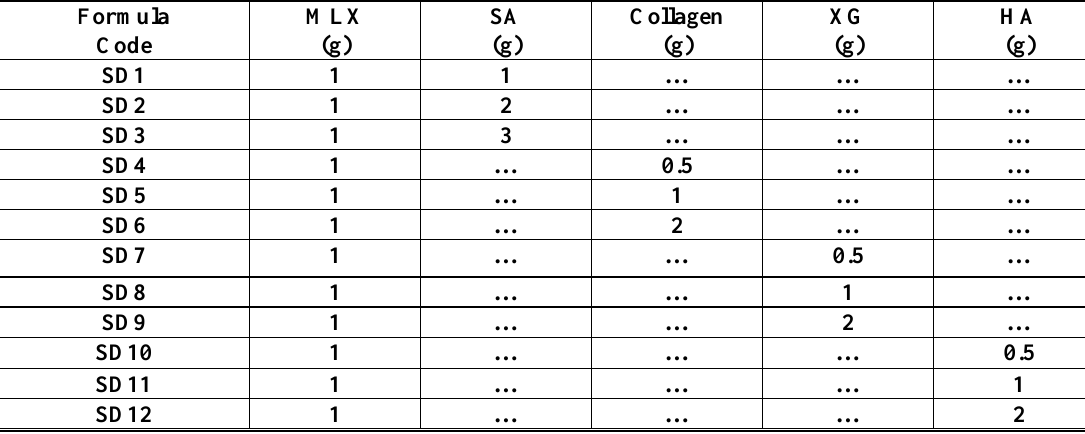
Table1. Composition of different SD formulas of MLX